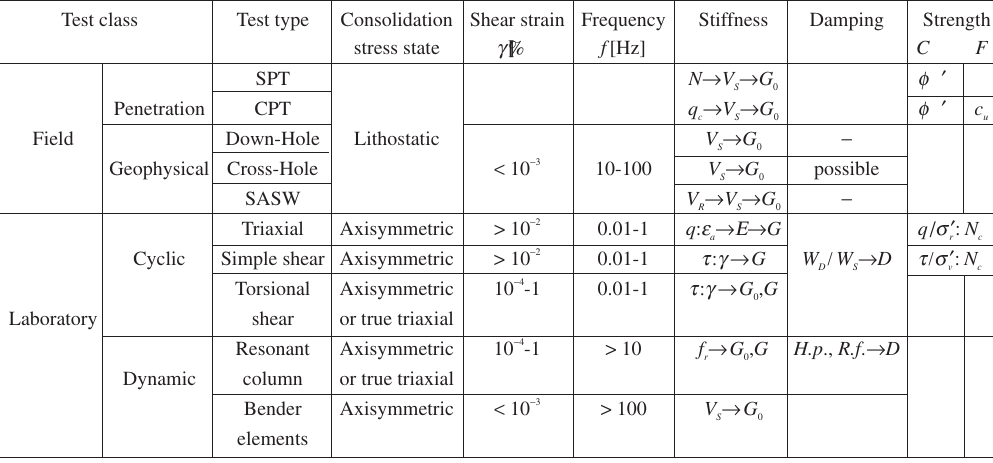
V = shear wave velocity; V = Rayleigh wave velocity ; f = resonant frequency; H.p. = half-power method; S R r R.f. = resonance factor method; N = SPT blow count; q = CPT tip resistance; φ′ = friction angle in effective c = undrained shear strength; C = coarse grained; F = fine grained soils; q / σ′ stresses; c u = number of ratio; τ/σ′ = shear/vertical stress ratio; N v c